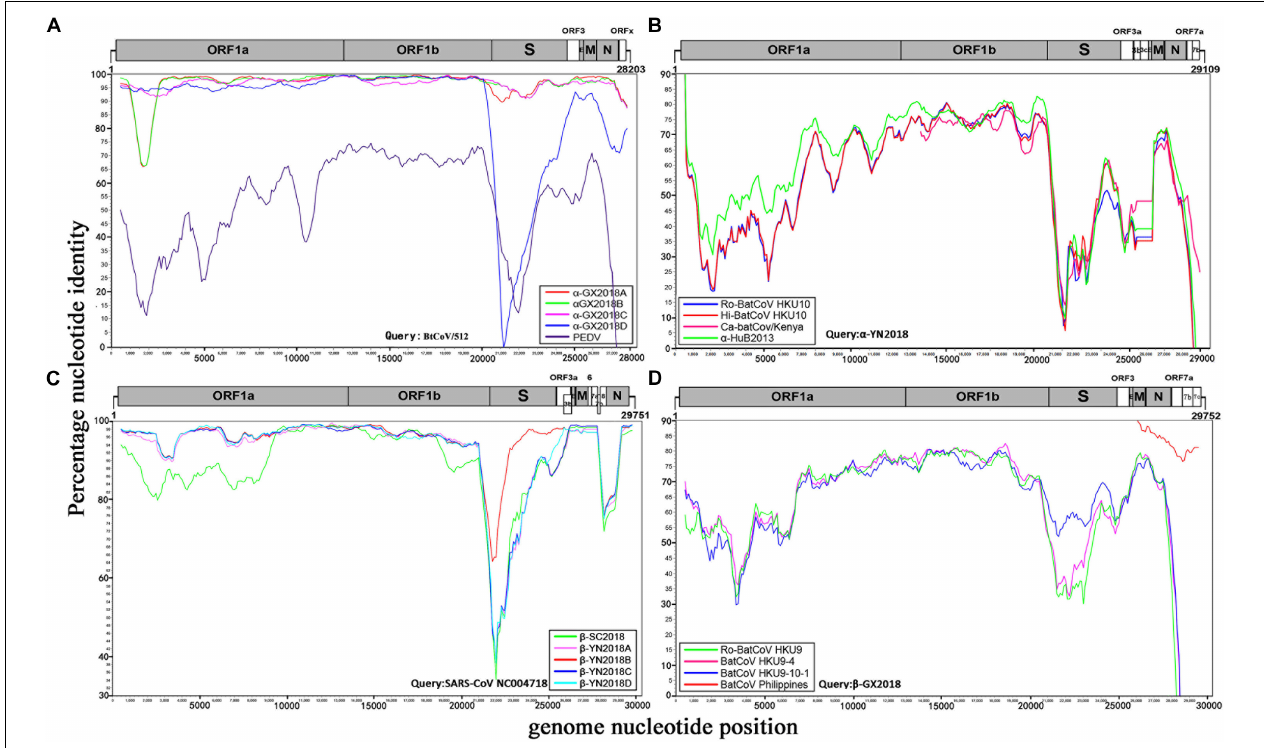
FIGURE 3 | Similarity plot analysis. (A) Full-length genome sequence of BtCoV/512 was used as a query sequence and α -GX2018A, B, C, D, and PEDV as reference sequences. (B) Full-length genome sequence of α -YN2018 was used as a query sequence and Ro-BatCoV HKU10, Hi-batCov HKU10, Ca-batCov/Kenya, and α -HuB2013 as reference sequences. (C) Full-length genome sequence of SARS-CoV SZ3 was used as a query sequence and β -YN2018A, B, C, D and β -SC2018 as reference sequences. (D) Full length genome sequence of β -GX2018 was used as query sequence and BatCoV HKU9-4, BatCoV HKU9-10-1, Ro-BatCoV HKU9, and BatCoV Philippines/Diliman as reference sequences. These analyses were performed with the Kimura model, a window size of 1000 base pairs and a step size of 100 base